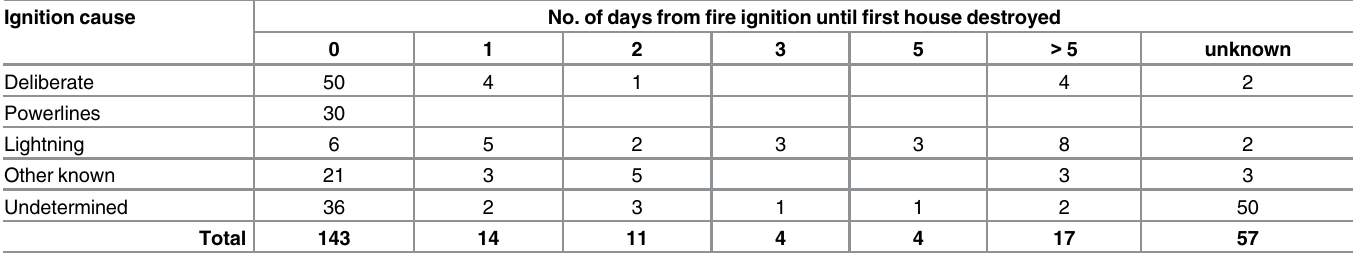
Table 4. The number of wildfires that destroyed houses from 1951 to 2015 classified by ignition cause and the number of days from fire ignition until the first house was destroyed. Ignition cause